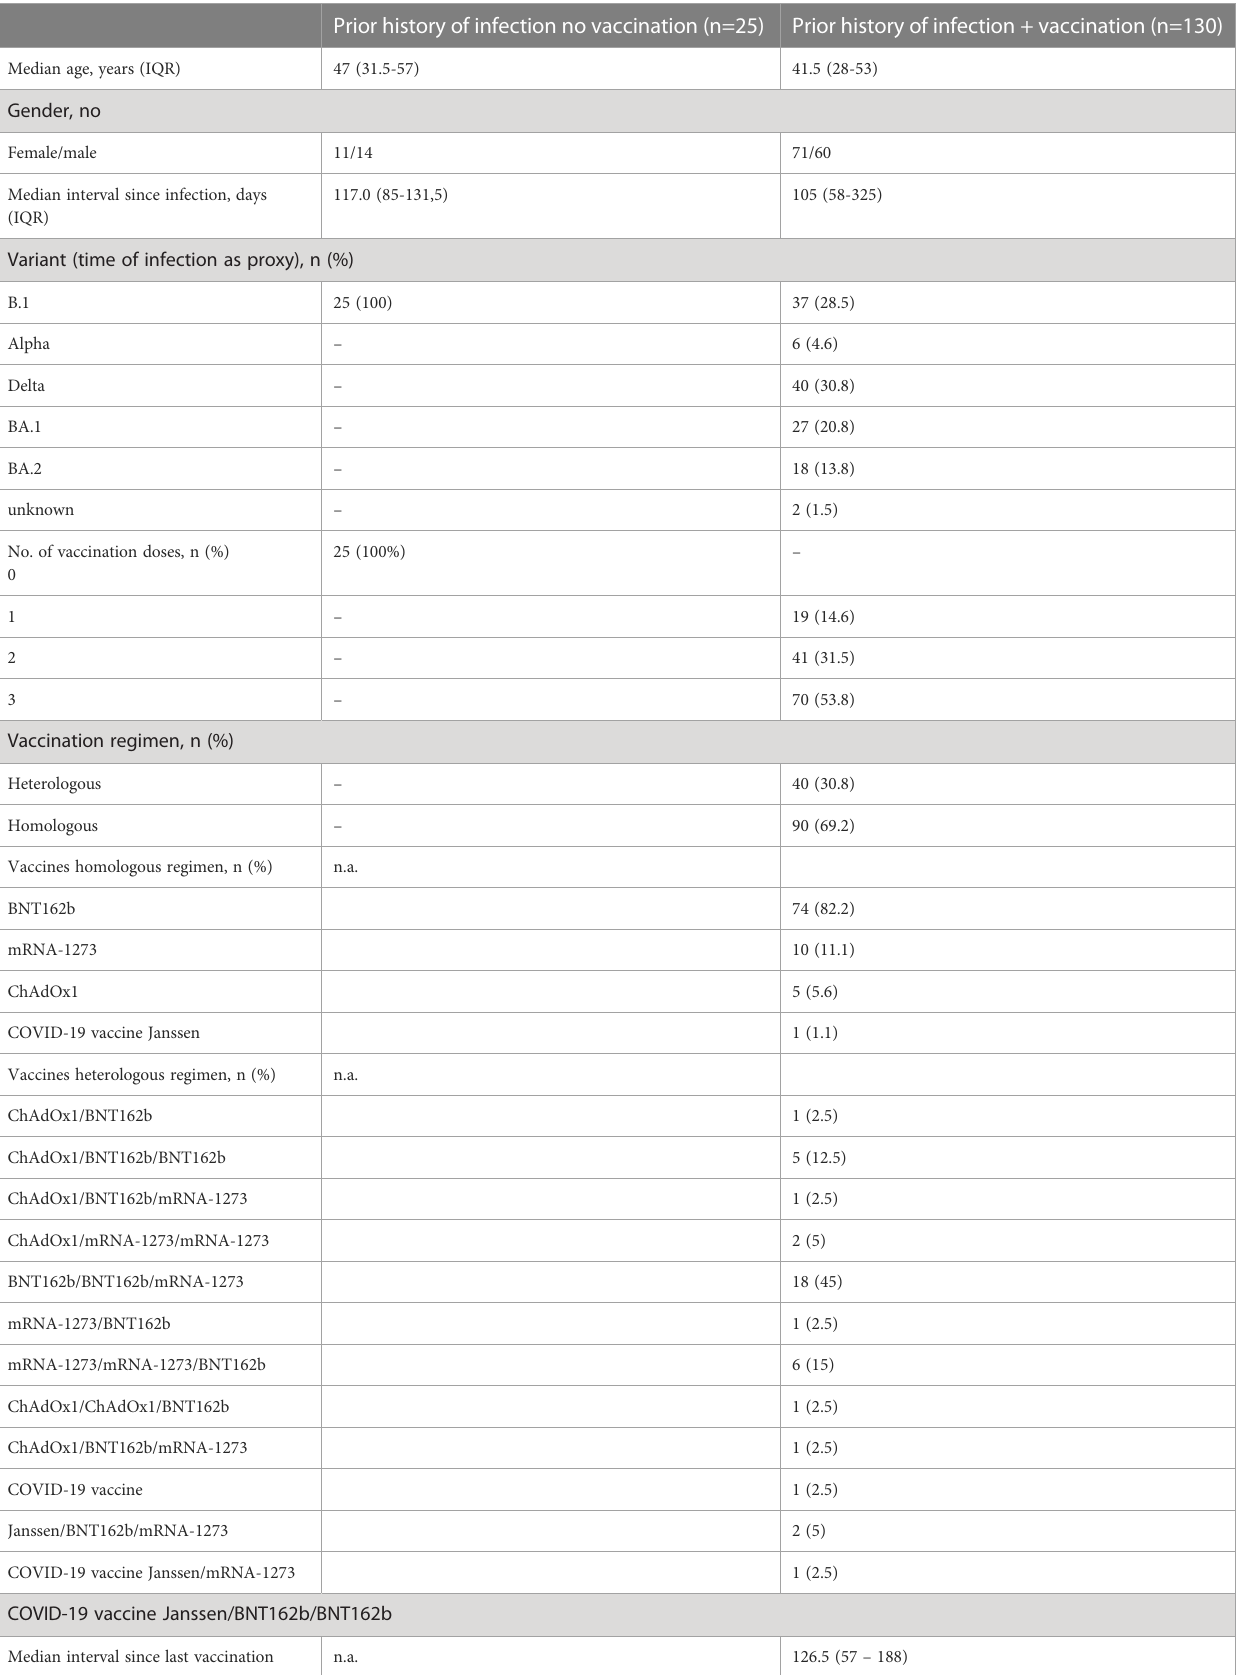
TABLE 1 Characteristics of the study cohort of convalescent